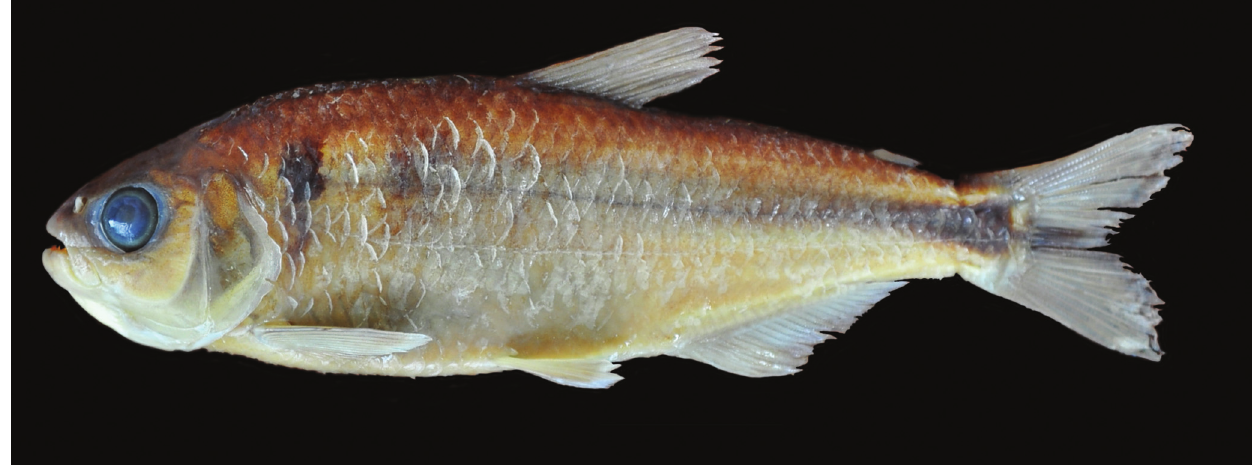
Fig. 1. Astyanax guaricana , holotype, MZUSP 112224, 95.6 mm SL, Brazil, Paraná State, rio Arraial, 25 o 42’29”S 48 o 58’25”W, at Reservoir of Guaricana Dam affluent of the rio Cubatão, coastal basin.